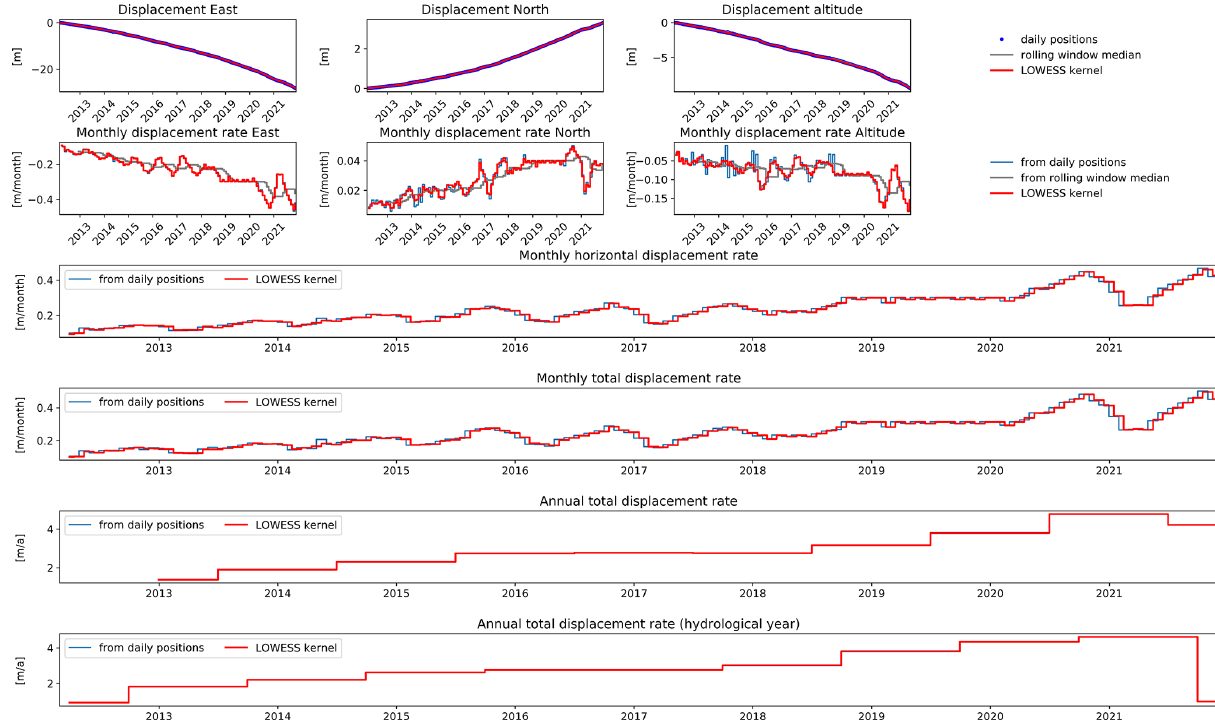
Figure A3. Station BH13 on the Breithorn/Bielzug rock glacier above Herbriggen; VS exhibits a steady acceleration downslope.